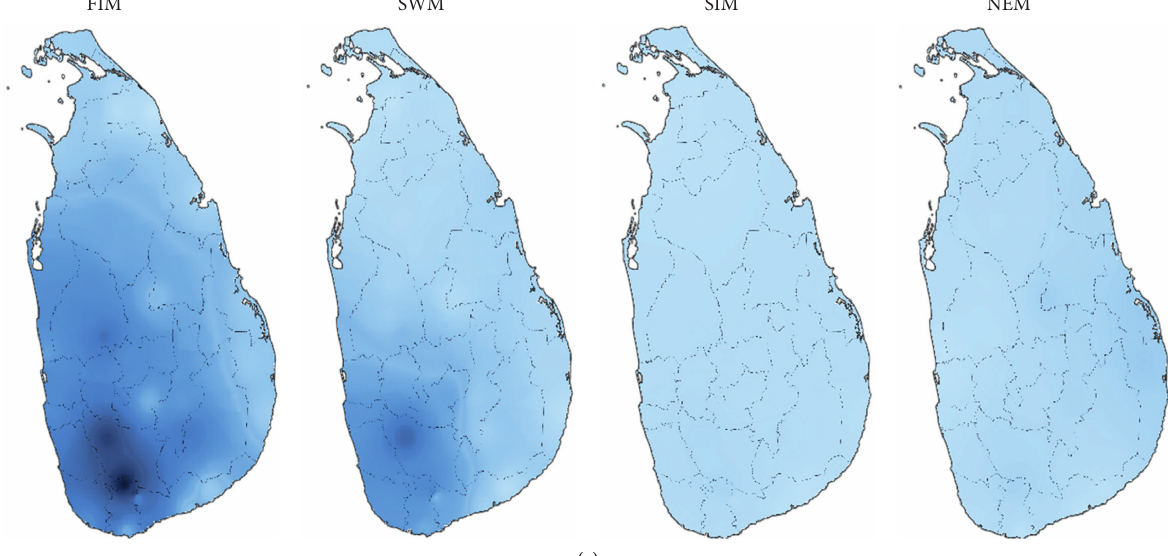
Figure 5: Mid-future indices under RCP4.5 (2041–2070). (a) For normalized DI. (b) For normalized WI. (c) Moisture